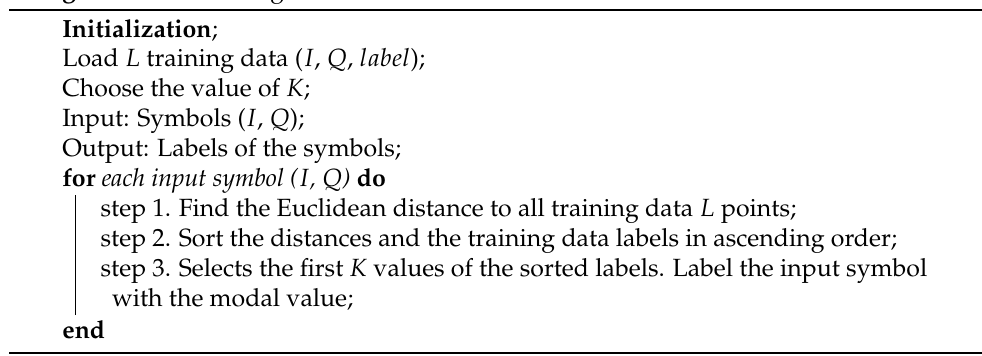
Algorithm 1: KNN algorithm for demodulators